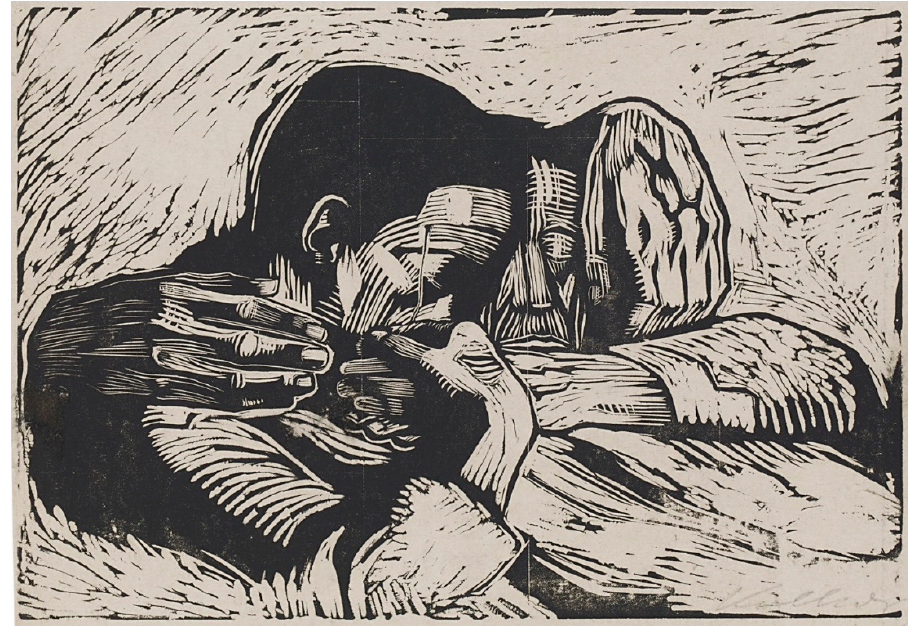
Figure 2. Käthe Kollwitz, Two Dead [Zwei Tote], 1920. Woodcut, 19.1 cm × 27.5 cm. Kn 158 IV, Kölner Kollwitz-Sammlung © Käthe Kollwitz Museum Köln.